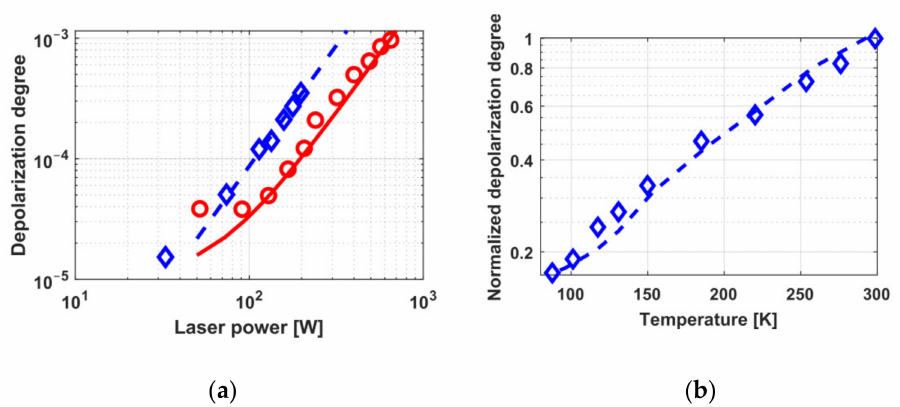
Figure 1. Thermally induced depolarization in TGG ceramics (diamonds—experimental points, dashed curve—theoretical approximation) as a function of laser radiation power at room temperature ( a ) and temperature ( b ). The graph for TGG crystals (circles—experimental points, solid curve— theoretical approximation) with [001] orientation from [24] is given for